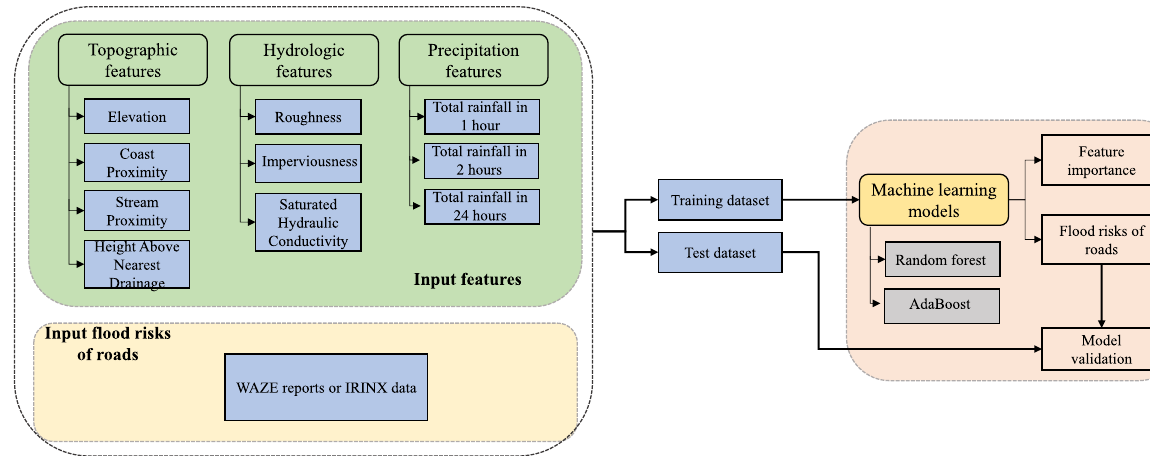
Fig. 1 Road flood risk prediction framework of machine learning